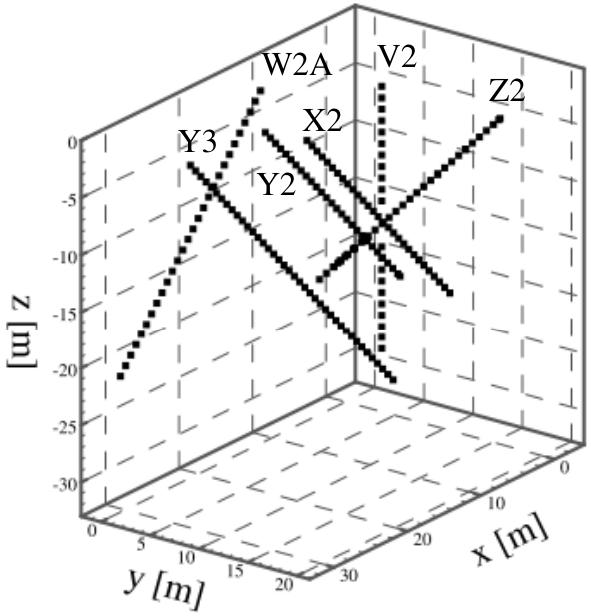
Fig. 1. Spatial locations along each borehole of Arizona data. Mod- ified after Guzman et al. (1996).